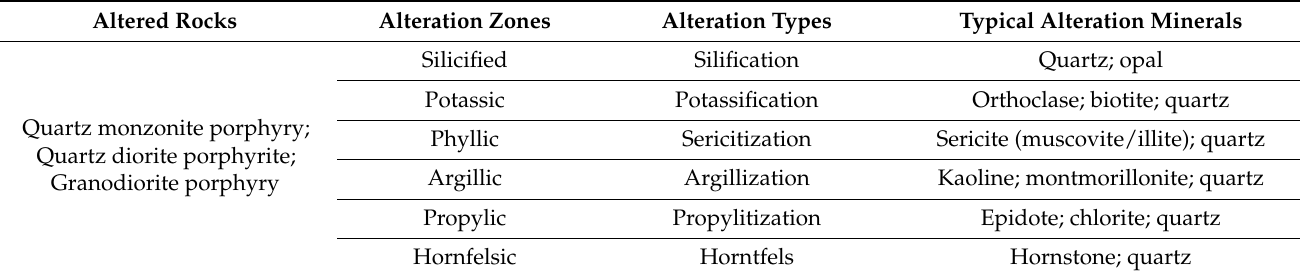
Table 1. The altered rocks and typical alteration minerals of different alteration types in porphyry copper